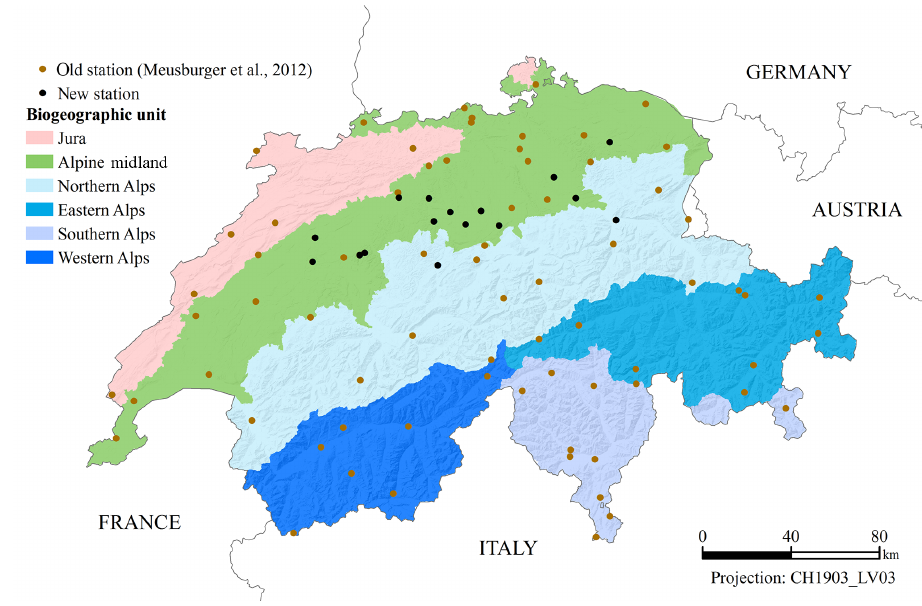
Figure 1. Biogeographic units and used gauging stations in Switzerland. Table 1. Datasets used as covariates for the spatiotemporal mapping of rainfall